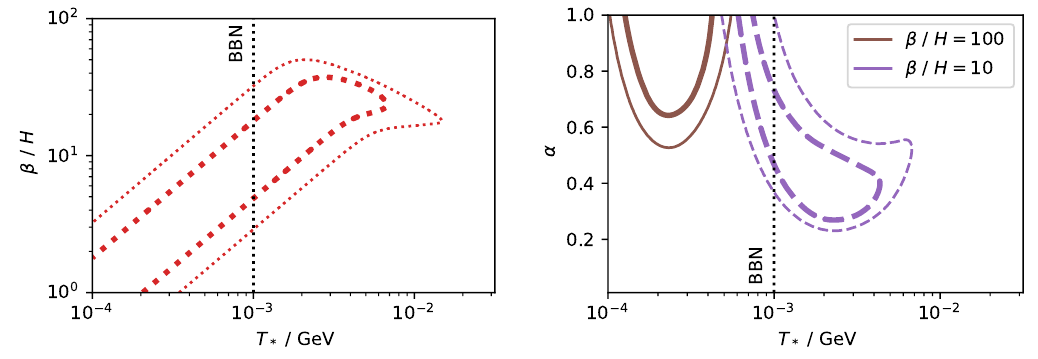
Figure 3: Left: Regions favoured by the NANOGrav signal for a vacuum PT, with = 1, shown as a function of the transition temperature T v w β/ H . Right: Same for a strong first order PT in a plasma, with v values of β/ H , as function of T ∗ and the energy budget α . The vertical line at one MeV indicates the onset of BBN, below which strong constraints apply to any models that alter the expansion rate of the